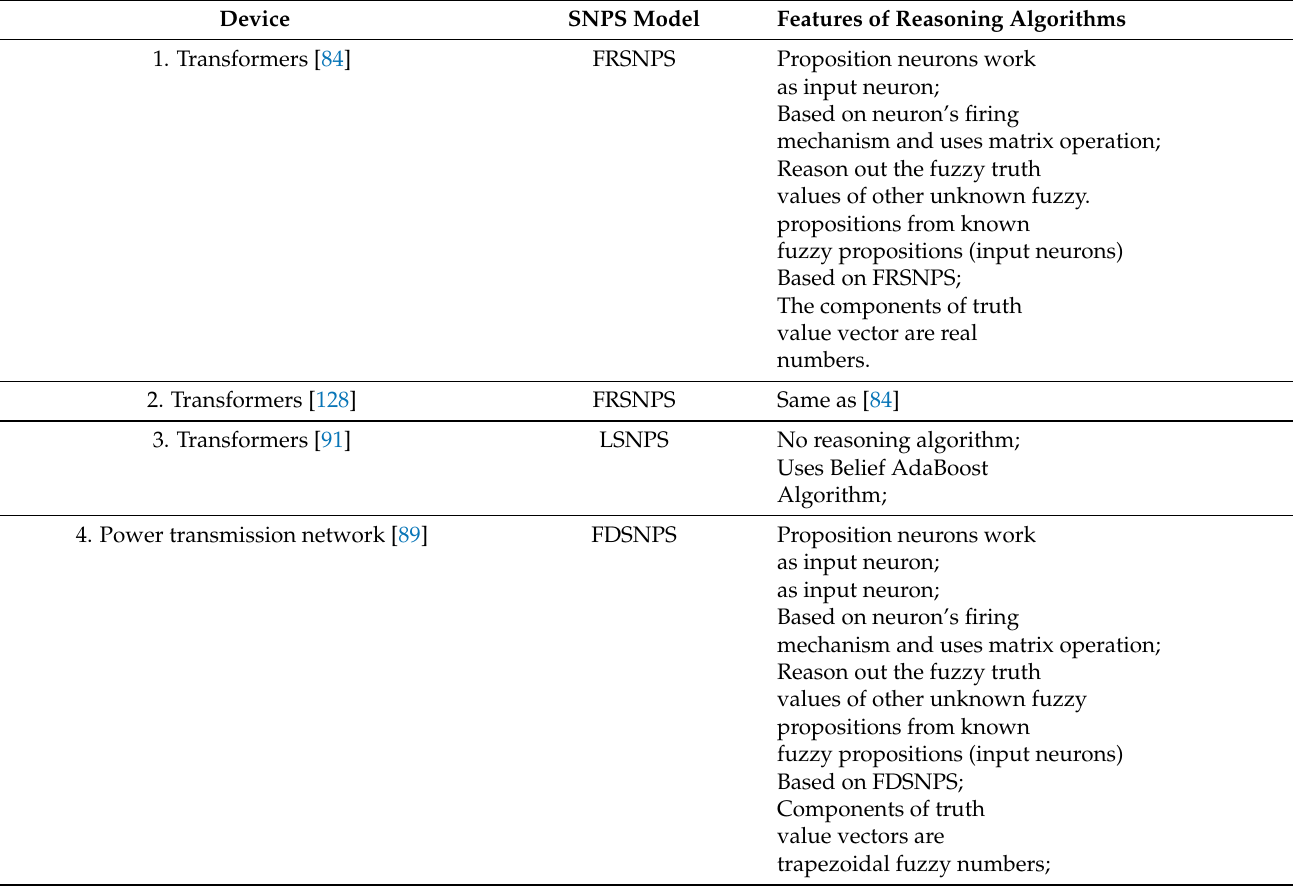
Table 7. Comparisons of reasoning algorithms for